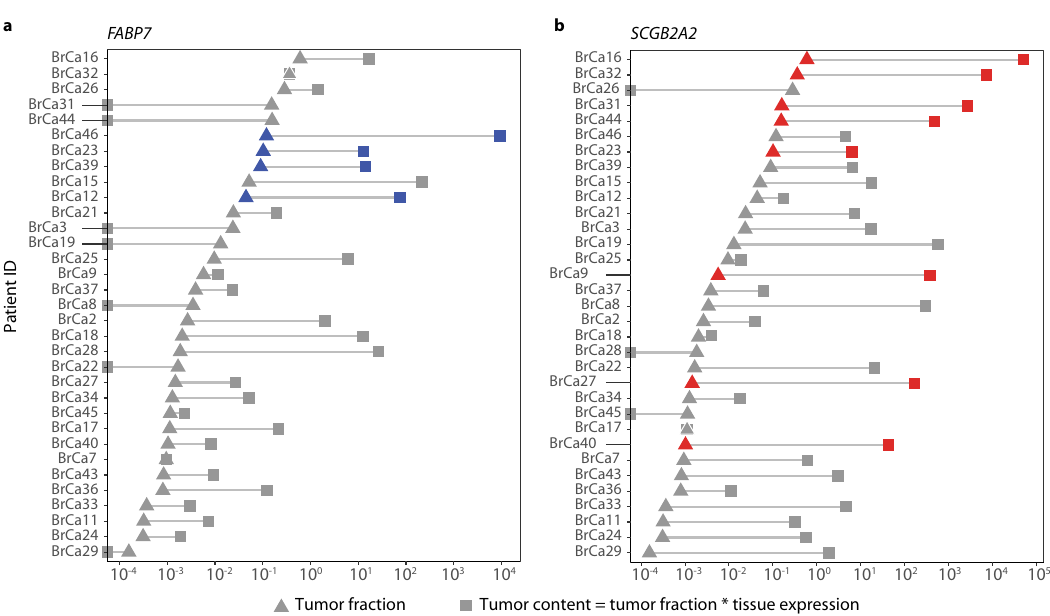
Fig. 5 The impact of tumor fraction and tumor content on the detectability of dark channel biomarker genes in cell-free RNA. Patient IDs plotted as a function of tumor fraction (triangles) and tumor content (squares) for a FABP7 and b SCGB2A2 . Patient IDs are ranked in descending order based on patient-speci fi c tumor fractions and are ordered identically in both panels. Blue and red symbols represent samples for which either FABP7 or SCGB2A2 was detected in plasma,